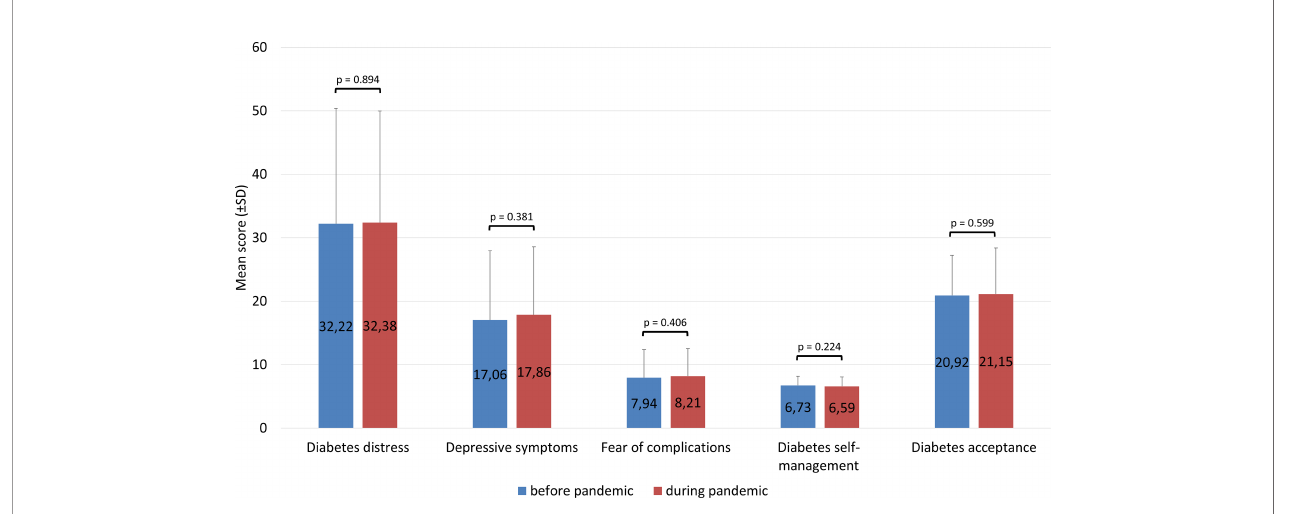
FIGURE 1 | Changes in questionnaire scores before vs. during the COVID-19